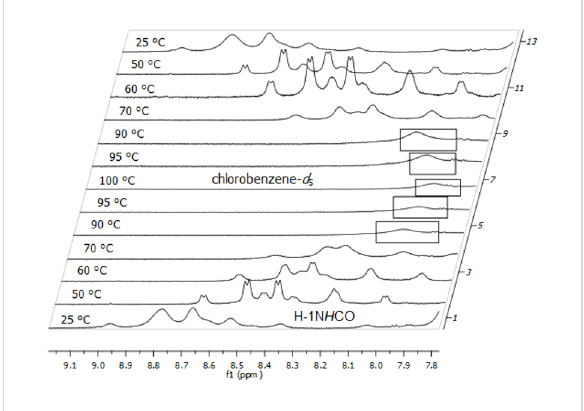
Figure 11: Temperature-dependent 1 H NMR (600 MHz) spectra of dimeric glycoconjugate 4 in chlorobenzene- d 5 , broadened signals near the coalescence temperature are